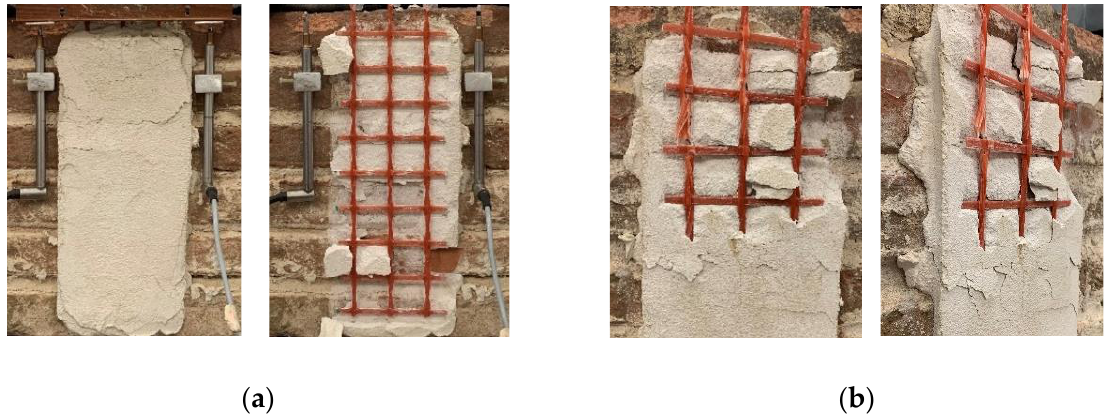
Figure 14. CRM-masonry joint failure modes: ( a ) MD mf D ms (specimen DS_290_120_CRM_W/D_2) and ( b ) MD mf D ms R (spec-